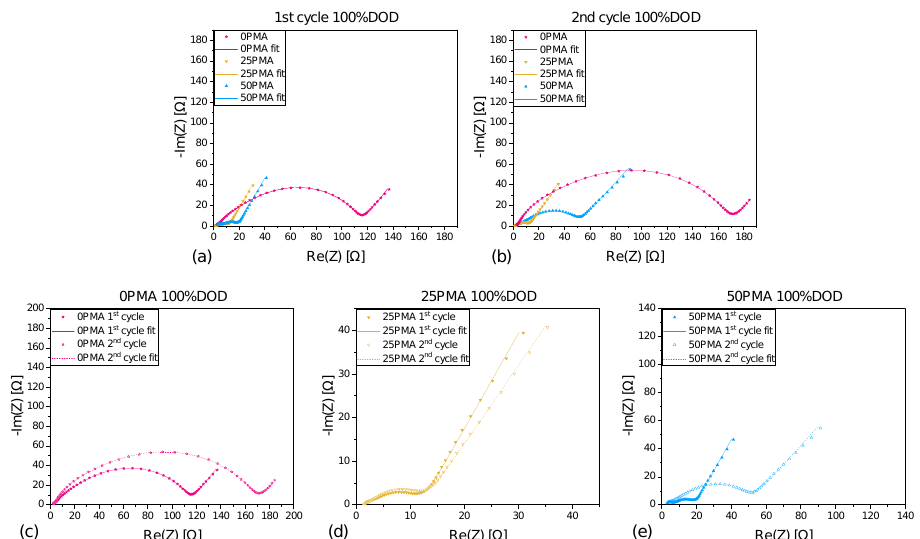
Figure 4. Comparison of EIS spectra for different electrode types with included fit of ( a ) 1st cycle and ( b ) 2nd cycle at 100% depth of discharge. Zoomed in spectra comparing 1st and 2nd cycle of ( c ) 0PMA, ( d ) 25PMA and ( e )